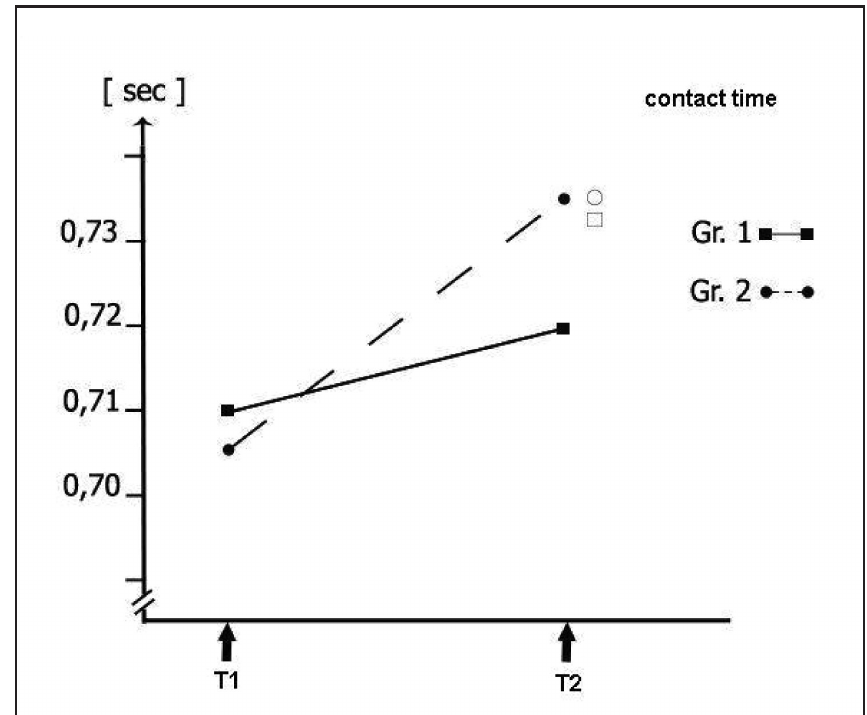
Figure 5: Contact time of the stand leg on the injured side during the gait in the comparison groups at the beginning of the investigation (T and at the end of the investigation (T the uninjured side in the therapy groups at the end of